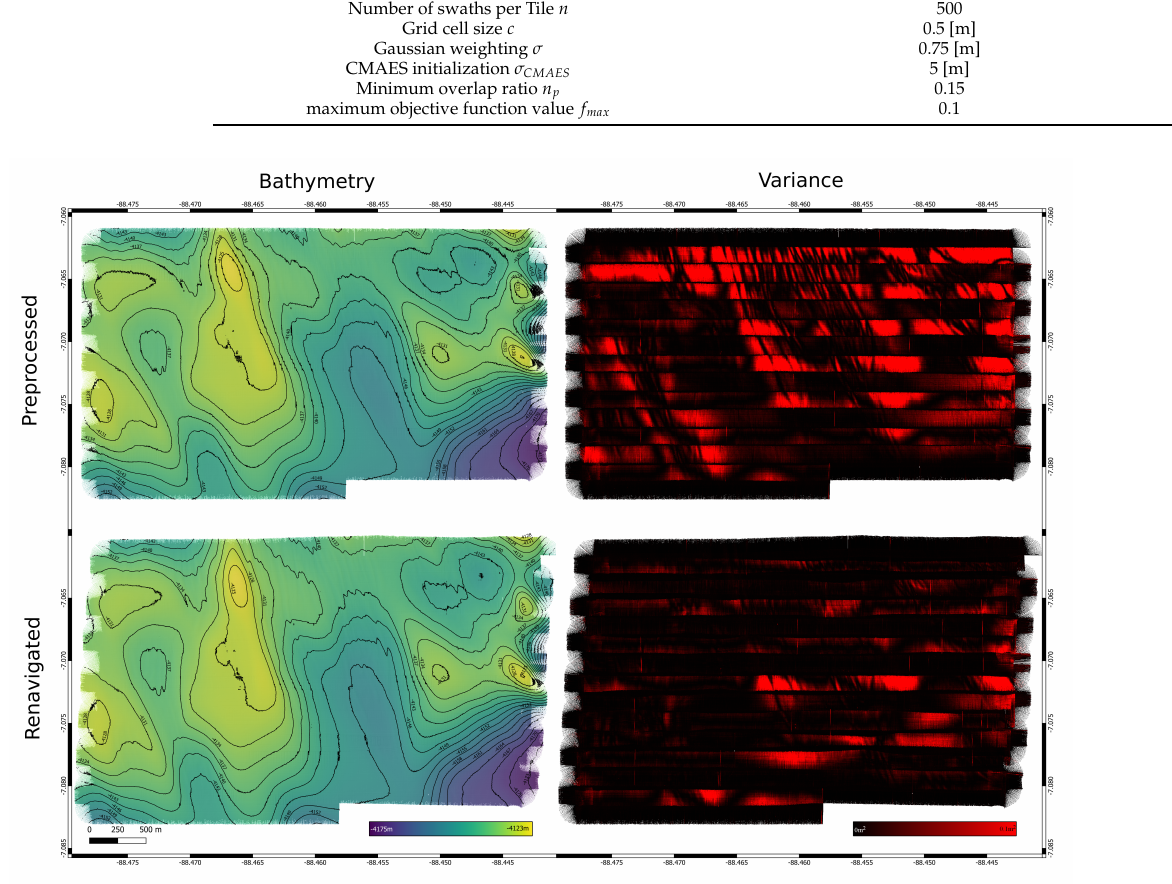
Figure 11. Bathymetry and variance for a 2 m resolution grid before and after navigation correction. Artifacts in the form of “waves” are clearly visible, despite an effort to reduce biases in the data as good as possible. The original navigation leads to overlapping tracks mismatching in height. Naturally this is visible in the variance, too. Applying the corrected navigation reduces these artifacts significantly.